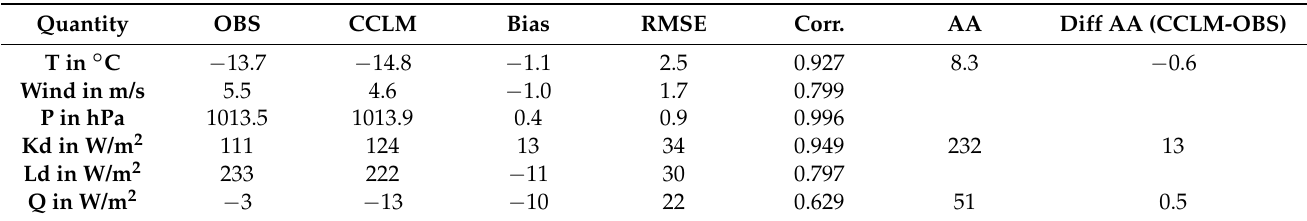
Table 2. Comparison of CCLM with near-surface observations (OBS) for April 2019 (2 m temperature (T), 10 m wind speed (wind), pressure (p), downward shortwave (Kd), downward longwave radiation (Ld) and net radiation (Q)). Average amplitude (AA) is the difference between the 90% and 10% percentiles (after subtraction of the low-pass filtered time series, see text). RMSE = root mean square error, Corr = correlation, number of values is